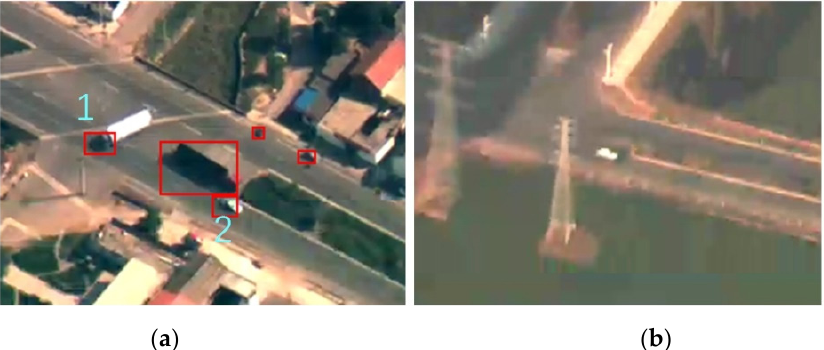
Figure 3. Example of missed white vehicles. Detection boxes 1 and 2 in ( a ) only detect the black cabin of the white truck or the black shadow around the white vehicle, while ignoring the real objects. ( b ) demonstrates thatthe only white object is not detected.